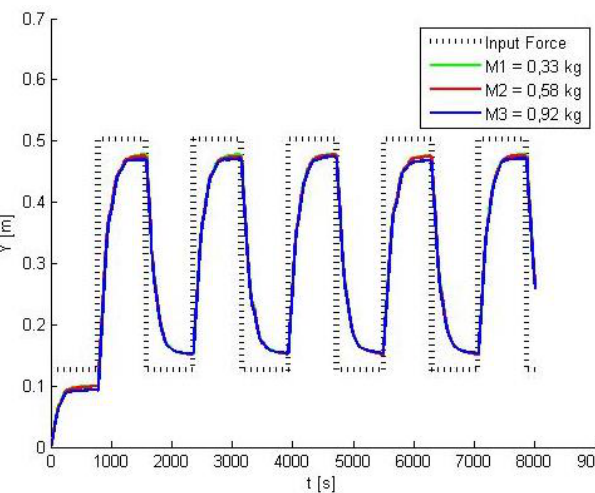
Fig. 13. Anti-swing 5DOF fuzzy logic regulator Y -axis position simulation results.